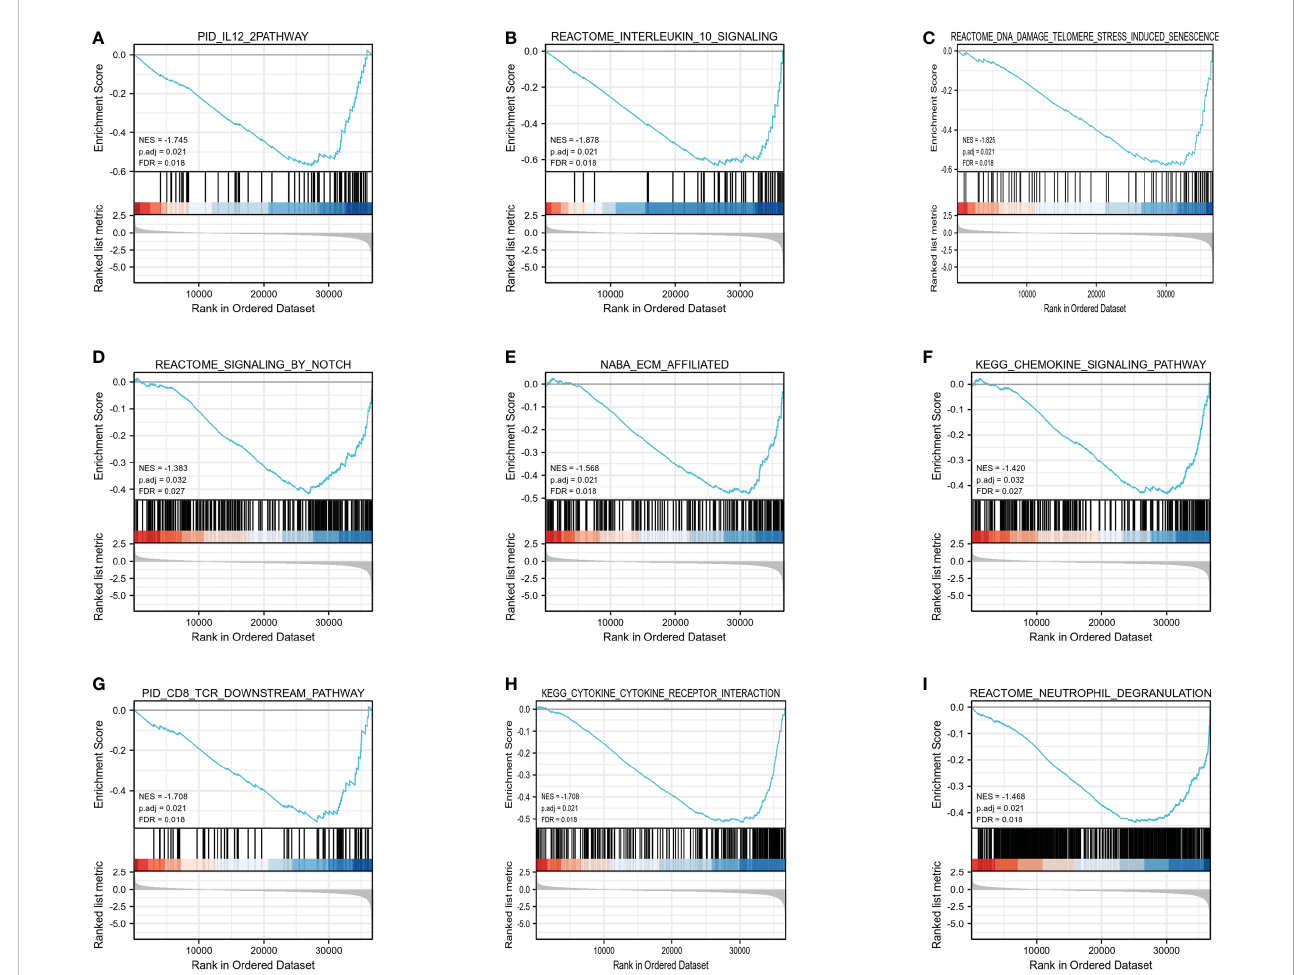
FIGURE 5 Enrichment plots from the gene set enrichment analysis (GSEA). (A) IL12 mechanism, (B) interleukin10 signaling, (C) DNA damage telomere stress induced senescence, (D) Notch signaling, (E) ECM af fi liated, (F) chemokine signaling pathway, (G) CD8 TCR downstream pathway, (H) cytokine-cytokine receptor interaction, and (I) neutrophil degranulation were substantially enriched in HIF1AN-associated BC. NES, normalized enrichment scores; FDR, false discovery